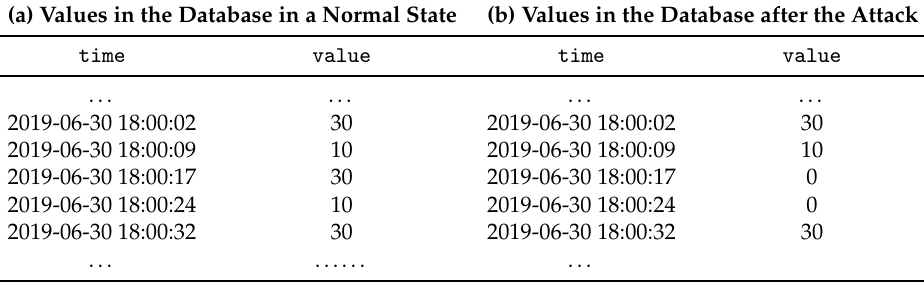
Table 3. Modification of values in the